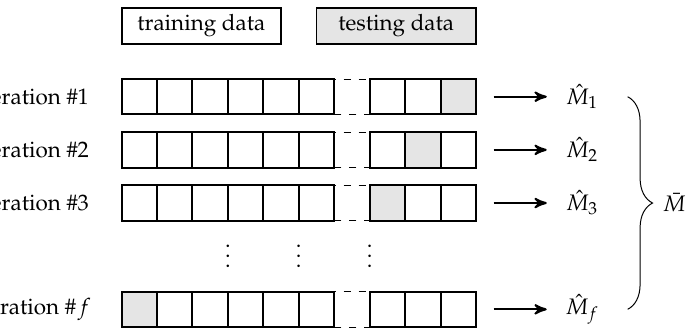
Figure 9. A scheme of f -fold cross-validation, where f ∈ N and f > 1. Training data are colored in white, while testing data are in